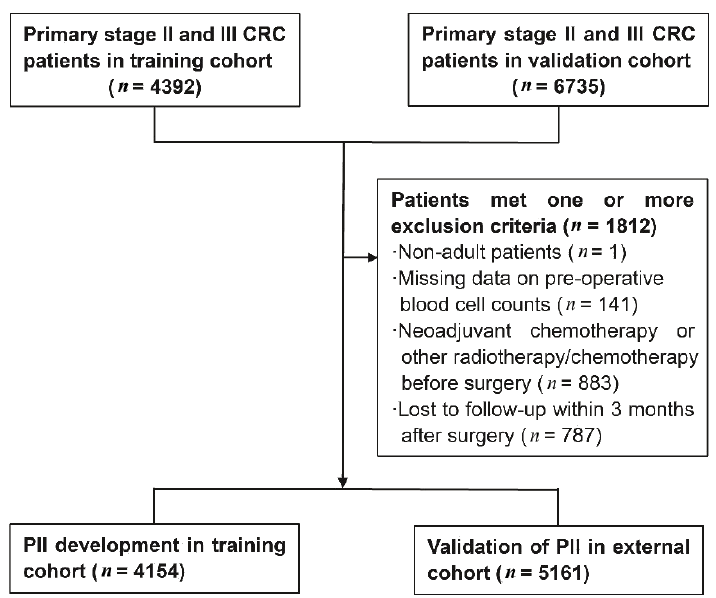
Figure 6. Flowchart of study patient selection.